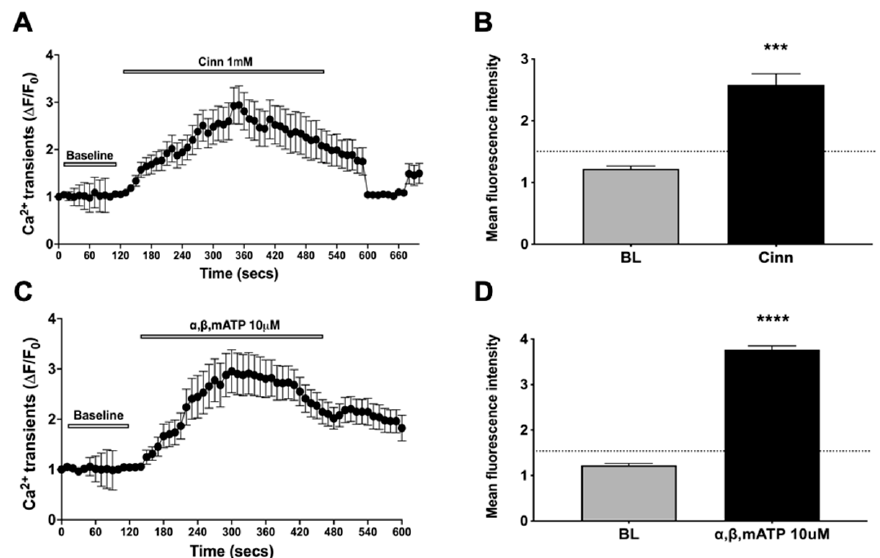
Figure 2. Characterization of vincristine-responsive gastroesophageal vagal afferent neurons. ( A ) Representative traces of calcium transients ( ∆ F/F0) evoked by cinnamaldehyde (cinn: 1 mM, 10 min) in 20 responsive nodose neurons; ( B ) Bar graph showing mean fluorescence intensity values for vehicle (KBS buffer, BL) and cinn (1.02 ± 0.09 vs. 2.58 ± 0.17, *** p < 0.001, n = 123 VCR-responsive neurons from three mice); ( C ) Representative traces of calcium transients ( ∆ F/F0) evoked by α , β -methylene ATP ( α , β ,mATP: 10 µ M, 10 min) in 20 responsive nodose neurons; ( D ) Bar graph showing mean fluorescence intensity values for vehicle (KBS buffer, BL) and α , β ,mATP (1.006 ± 0.08 vs. 3.764 ± 0.08, **** p < 0.0001, n = 192 VCR-responsive neurons from three